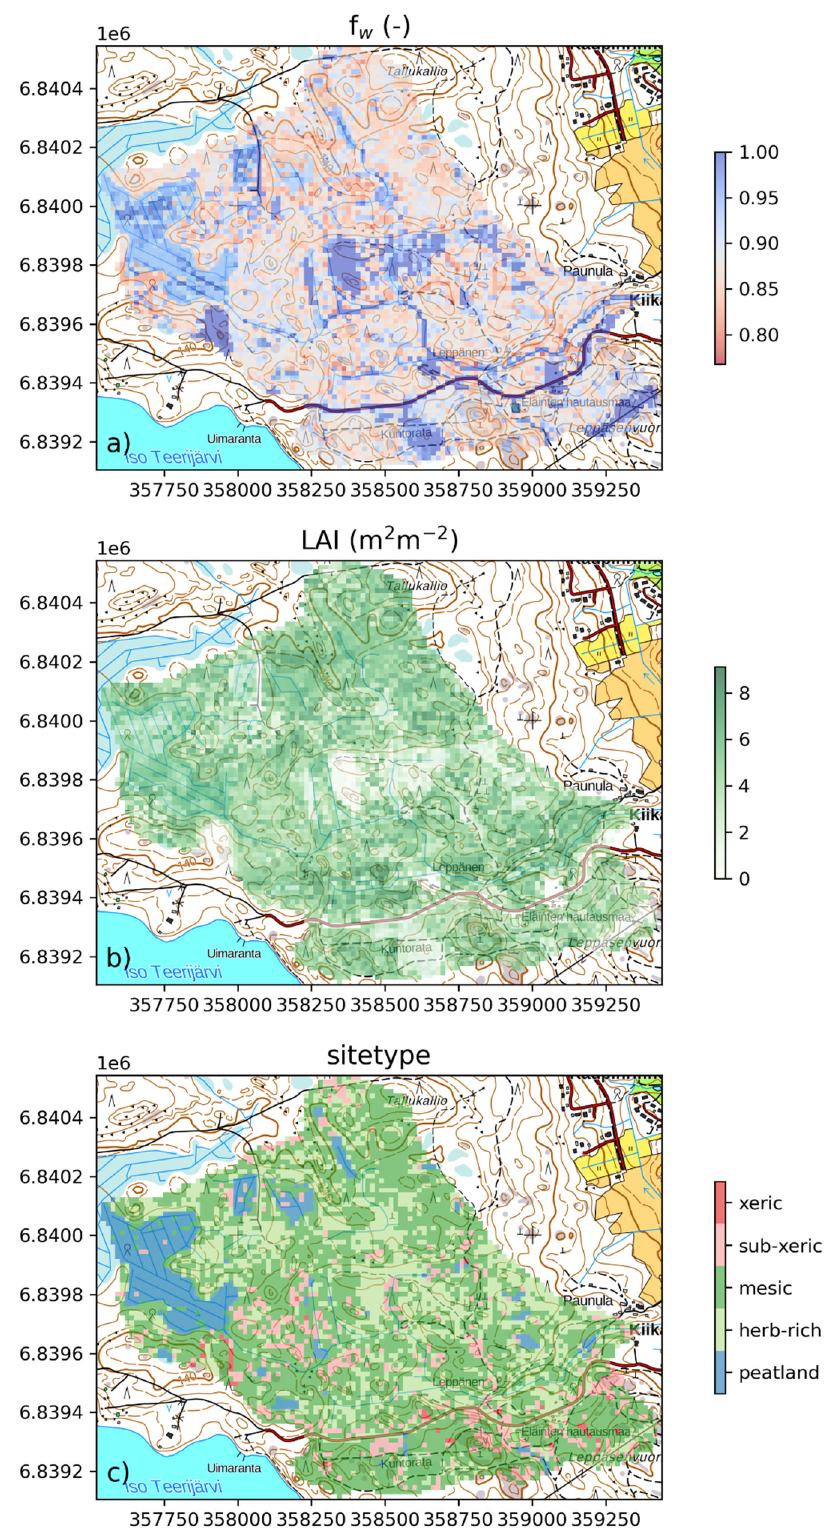
Figure 8. The mean May–Sept soil moisture modifier (f w , a ) for the 2000–2015 period at Paunulanpuro; the forest one-size leaf-area index (LAI, b ) and forest site type ( c ) based on multi-source National Forest Inventory (mNFI) data. The values f w < 1 indicate grid cells where soil-moisture limitations can be present. The rasters overlay a topographic base map of Finland.